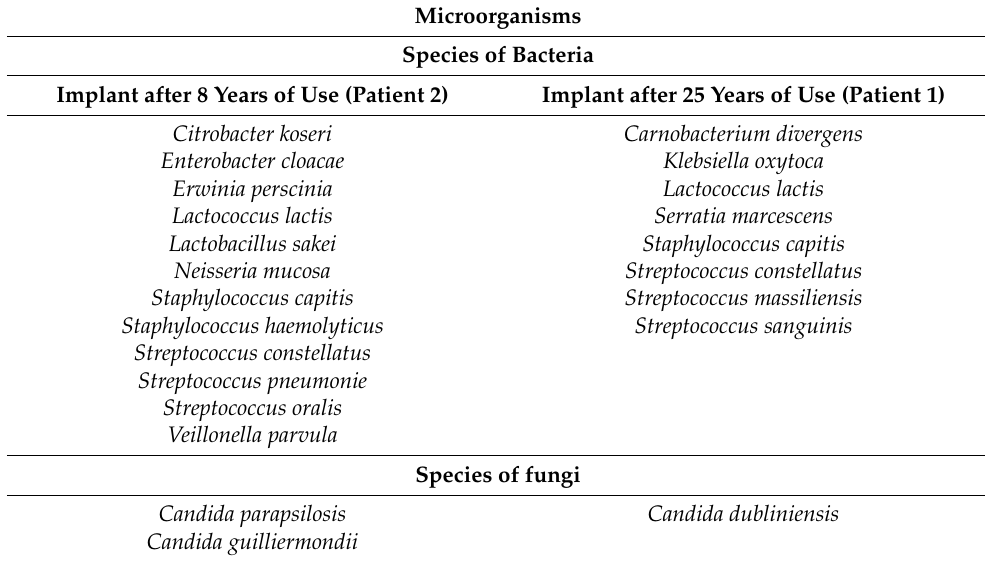
Table 2. Microorganisms isolated from dental implants of the patients with full-blown peri-implantitis identified by the matrix-assisted laser desorption/ionization time-of-flight mass spectrometry (MALDI TOF MS) method.